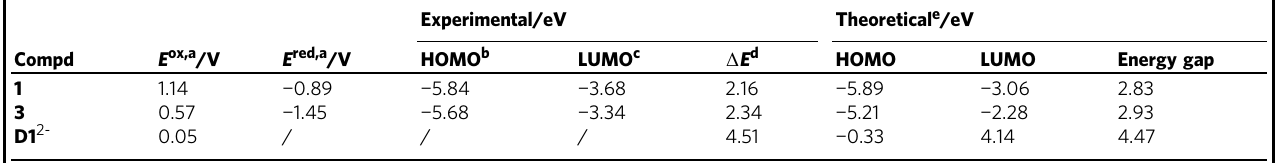
Table 2 Electrochemical properties and DFT calculated results of 1, 3 and D1 2 −